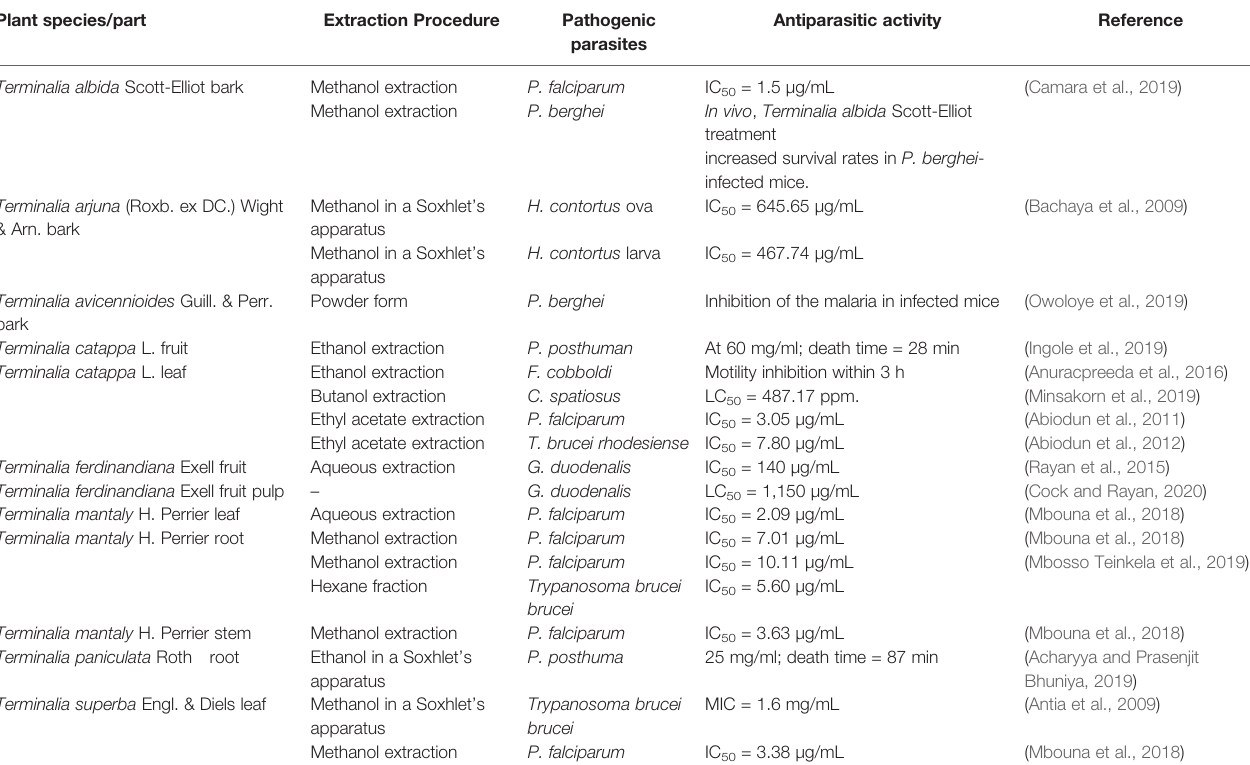
TABLE 9 | Antiparasitic activity of Terminalia sp. against pathogenic